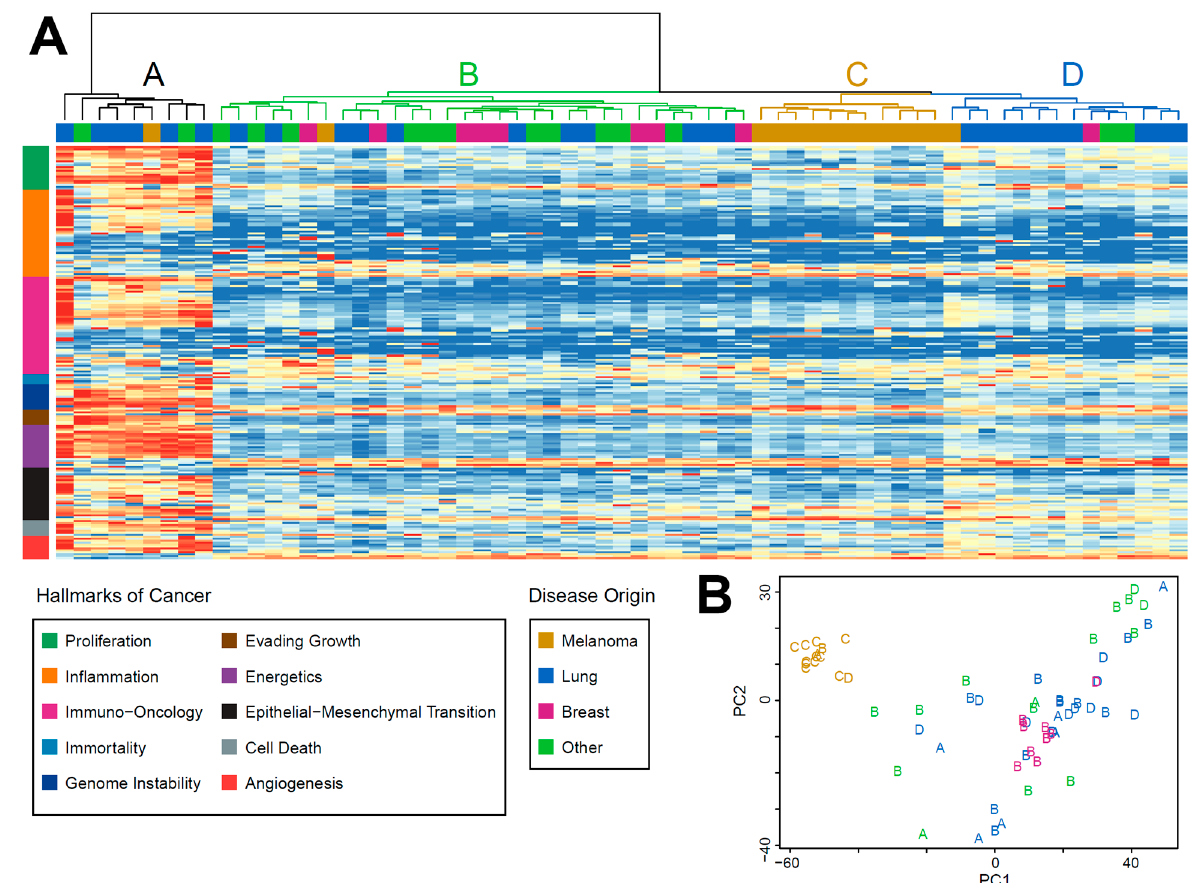
Figure 4. ( A ): Unsupervised hierarchical clustering of expression signatures based on the hallmarks of cancer in 65 UAMS BM samples. Scores are scaled between 0 (blue) and 1 (red), with higher values representing higher transcript abundances. Four clusters were formed. Notably, clusters C and D are predominantly melanoma and lung BM samples, respectively, and cluster A has a very transcriptionally active phenotype. ( B ): Principal component analysis of RNA sequencing data from 65 UAMS samples. Letters denote the RNA cluster from Figure 4A and colors denote the origin of disease. Melanoma BMs (orange letters) form a distinct cluster in both analyses, but the hallmark clusters are not replicated in the PCA, suggesting a genuine biological origin and not a batch effect or simple reflection of the origin of metastases. Signature names and references are detailed in order in Table S3.